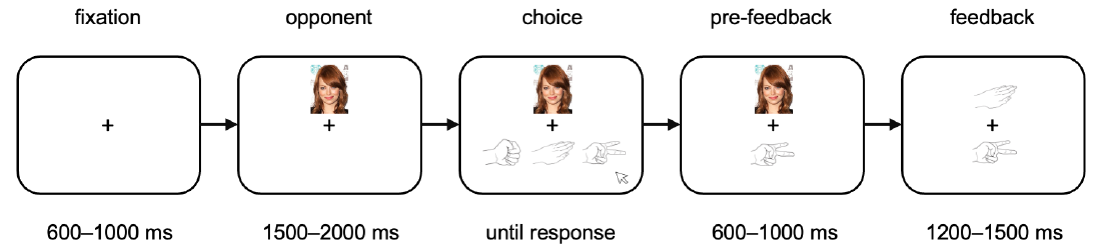
Figure 1. RPS task, with timing details. Participants were first shown their opponent’s face, then used the mouse to make their choice. Feedback came when participants saw the opponent’s choice.